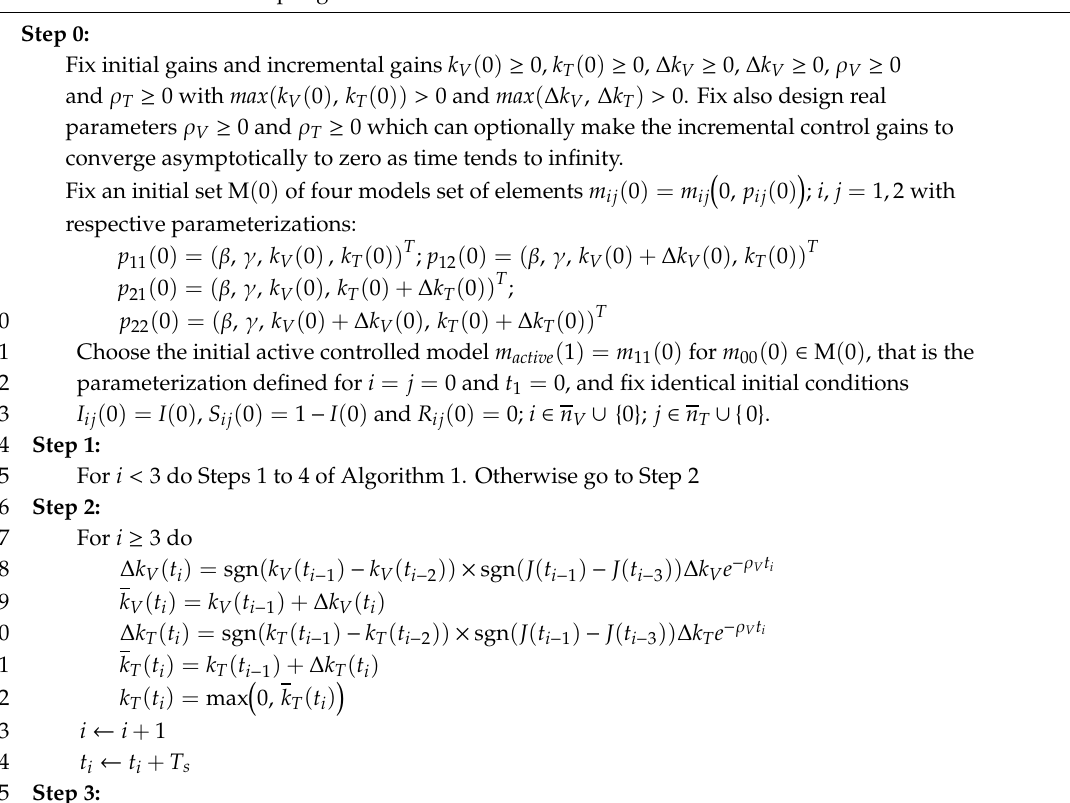
Algorithm 4 The switching time instants to update the parameterization are integer multiples of a prefixed basic minimum constant sampling